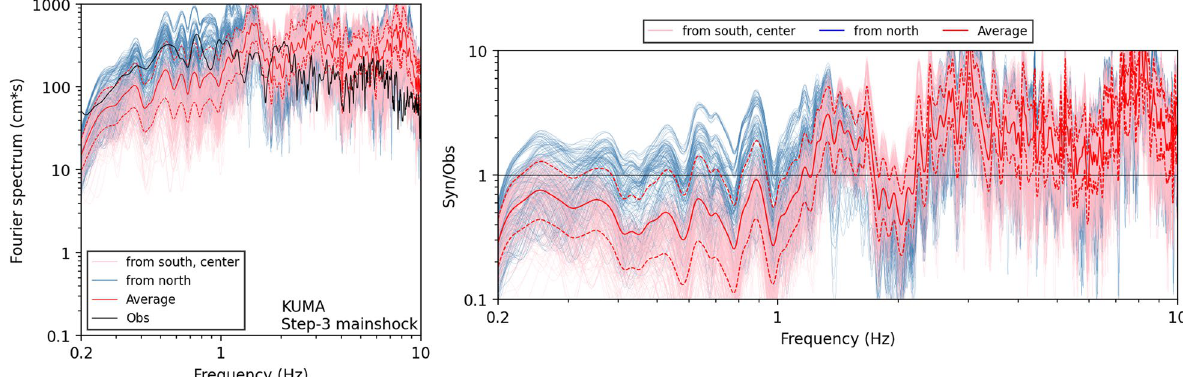
Fig. 18 Sensitivity of the prediction at KUMA to the rupture scenario. (Left) Blue and pink lines indicate the synthetic Fourier spectra of rupture scenarios that begin from the south or center (pink) and north (blue), respectively. Red solid and dashed lines indicate the average of all the rupture scenarios and the range of one standard deviation, respectively. The black line indicates the observed spectrum. (Right) Blue, pink, and red lines indicate the ratio of the lines of same type in the left panel to the observed